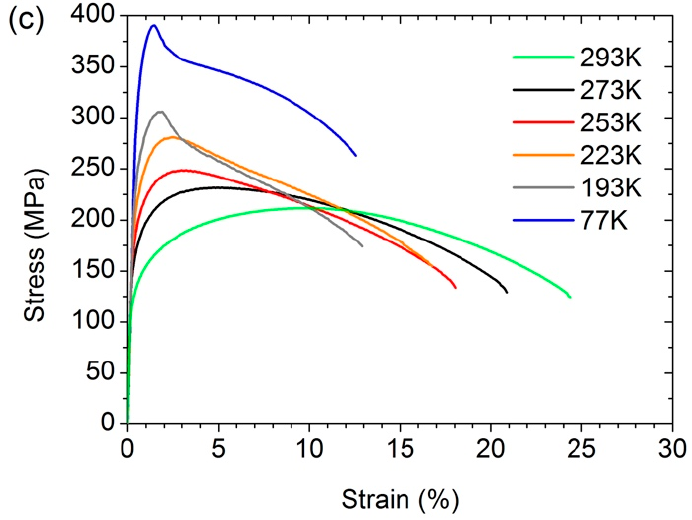
Figure 4. The stress–strain curves obtained at different deformation temperatures for the Al–0.4Zr alloy after ( a ) HPT-processing, ( b ) after HPT-processing and subsequent annealing at 503 K for 1 h, and ( c ) after HPT-processing, subsequent annealing, and additional HPT deformation to 0.25 revolutions.